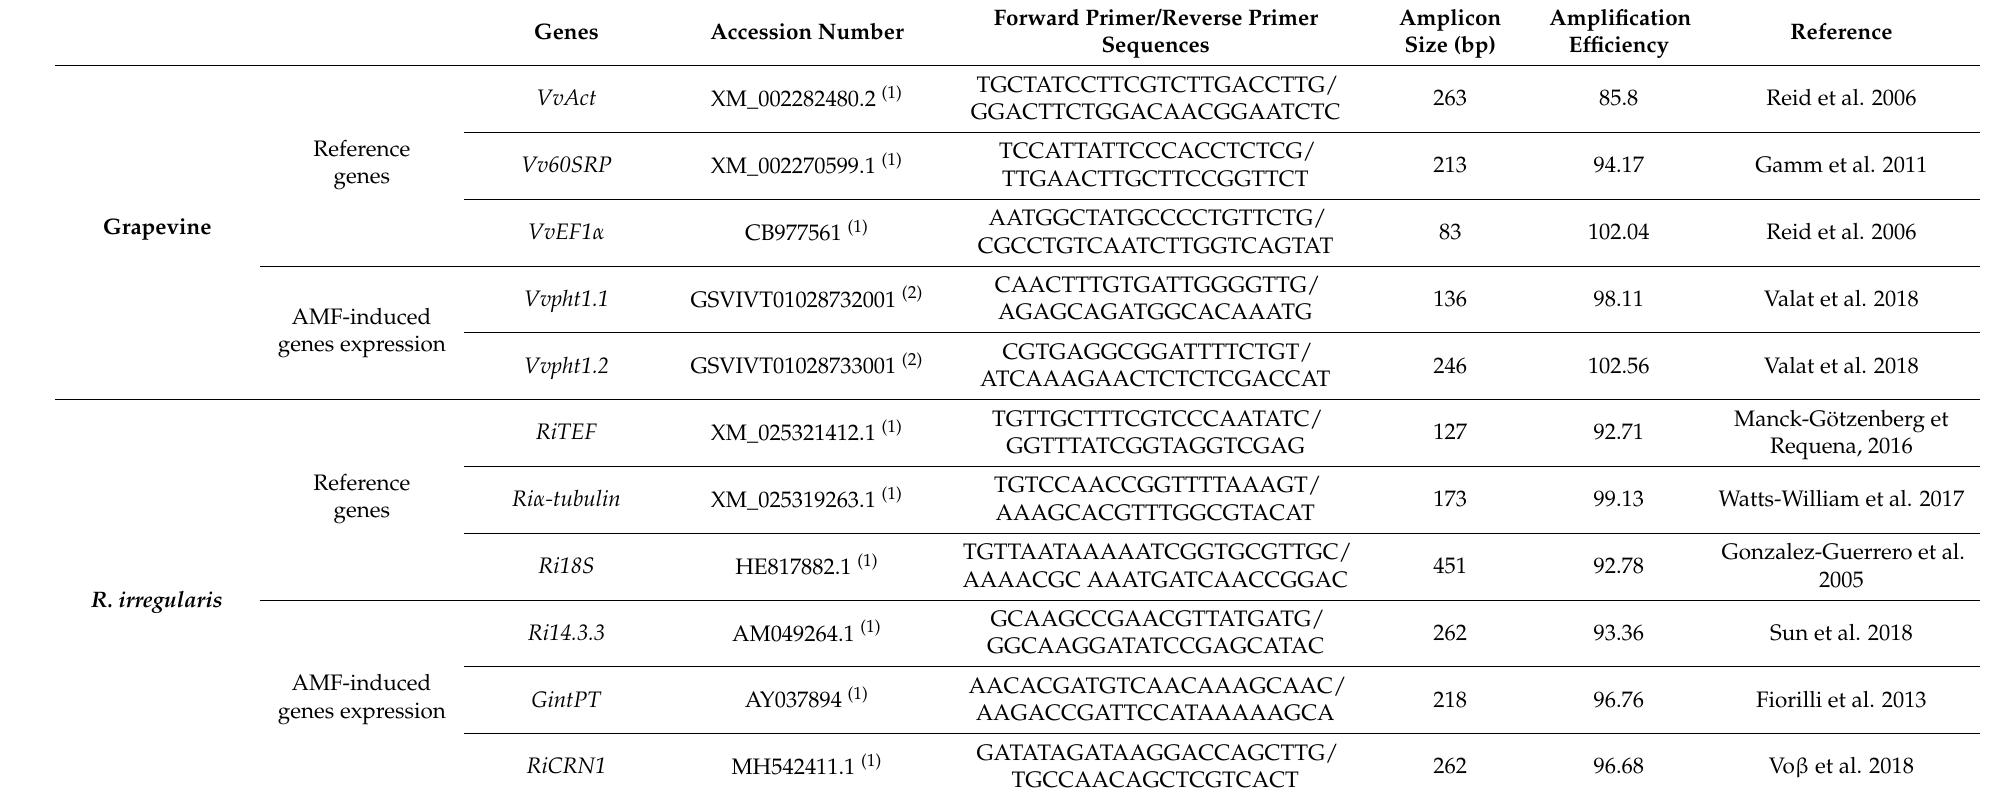
Table 1. Oligonucleotide primers. (1) : GenBank; (2) : Genoscope